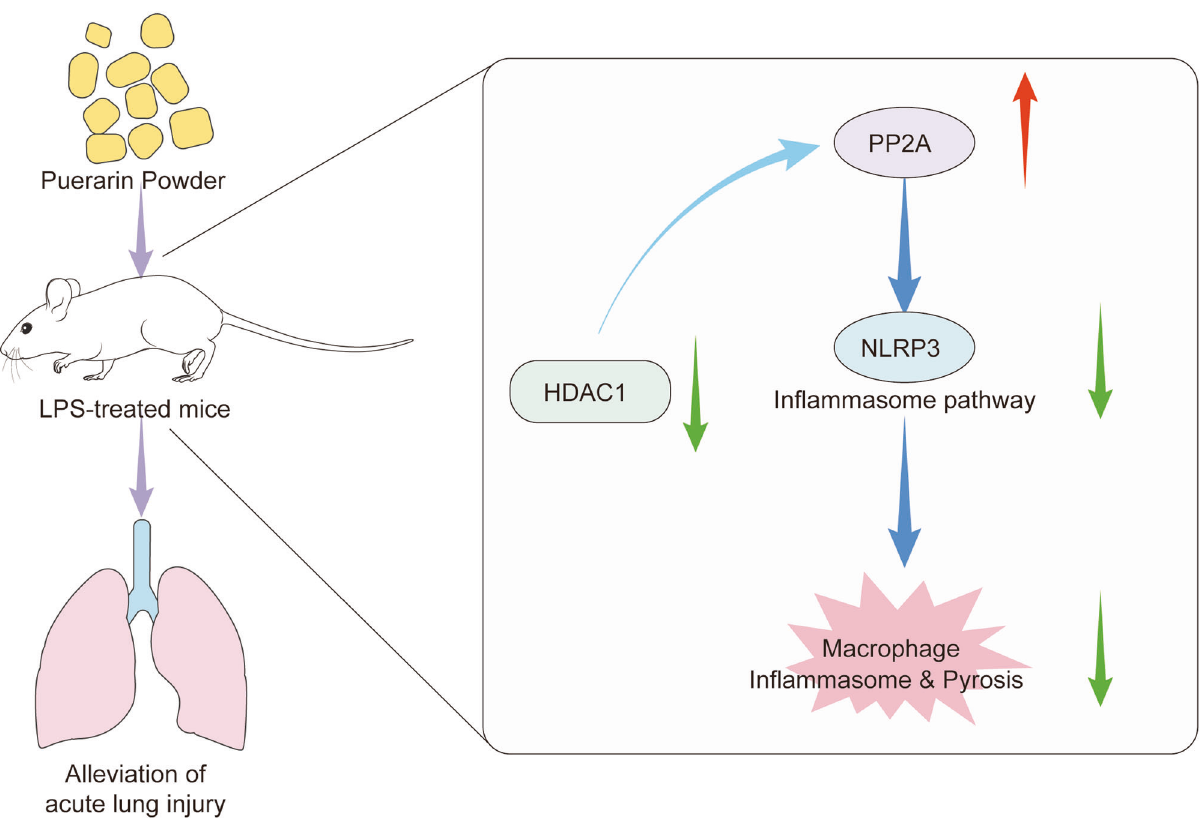
Fig. 6 Schematic map of role of Puerarin in ALI. Puerarin ameliorated ALI by modulating NLRP3 in fl ammasome-induced